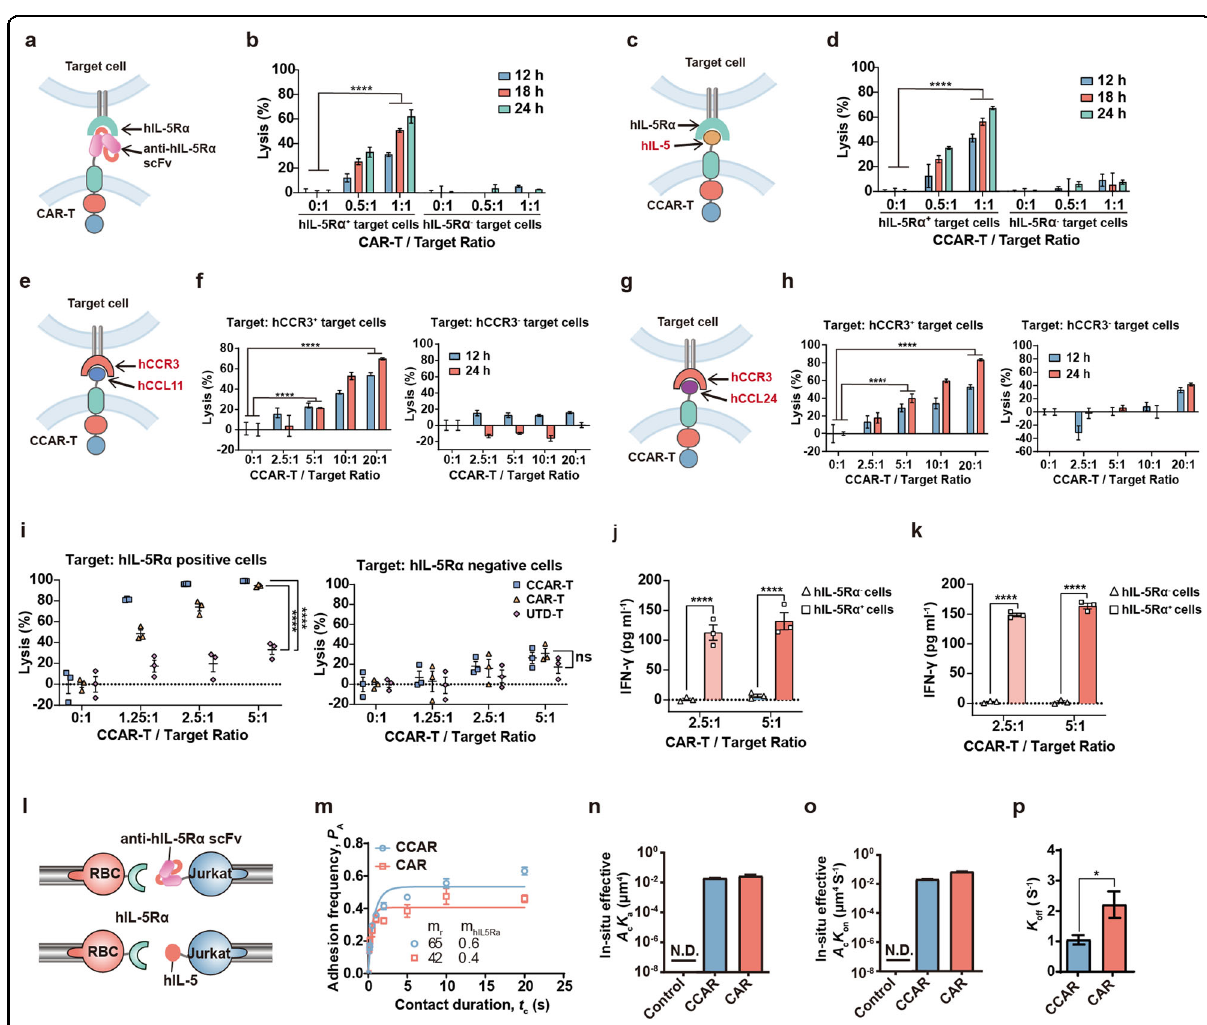
Fig. 1 Design, characterization, and comparison of eosinophil-targeting CCAR-T cells. a Design of the anti-hIL-5R α CAR-T cells using the scFv derived from human IL-5R α mAb as the antigen-binding domain. b Cytotoxic activity of anti-hIL-5R α CAR-T cells as determined by a bioluminescence assay using luciferase-expressing hIL-5R α + or hIL-5R α – U2OS cells as target cells. Differences between the CAR-T cell-treated and control group were examined by the two-way ANOVA, **** P < 0.0001. c Design of the hIL-5-anchored CCAR-T cells using human IL-5 as the antigen-binding domain. d Cytotoxic activity of hIL-5-anchored CCAR-T cells. Two-way ANOVA, **** P < 0.0001. e Design of the hCCL11-anchored CCAR-T cells. f Cytotoxic activity of the CCL11-anchored CCAR-T cells against target cells. Two-way ANOVA, **** P < 0.0001. g Design of the hCCL24-anchored CCAR-T cells. h Cytotoxic activity of the CCL24-anchored CCAR-T cells to target cells. Two-way ANOVA, **** P < 0.0001. i Cytotoxic activity of anti-hIL-5R α CAR-T cells or hIL-5-anchored CCAR-T cells from healthy human donors against hIL-5R α + U2OS cells. Two-way ANOVA, **** P < 0.0001. UTD-T, un-transduced T cells. j , k The production of interferon- γ (IFN- γ ) in the supernatant of anti-hIL-5R α CAR-T cells ( j ) or hIL-5-anchored CCAR-T cells ( k ) from healthy human donors after coculture with target cells for 24 h was determined by ELISA kit. Two-way ANOVA, **** P < 0.0001. l Schematic diagram of the bio- membrane force probe assay for the adhesion frequency assay. m Binding speci fi cities ( P a ) of anti-hIL-5R α CAR/hIL-5-anchored CCAR and hIL-5R α as measured by adhesion frequency with different contact duration. n In-situ effective af fi nity ( A c k a ) of the interaction between anti-hIL-5R α CAR-hIL-5R α or hIL-5-anchored CCAR-hIL-5R α and hIL-5R α . N.D., not detected. o In-situ effective on-rate ( A c k on ) of the anti-hIL-5R α CAR-hIL-5R α bond and the hIL- 5-anchored CCAR-hIL-5R α bond. p Average off-rate ( k off ) of the anti-hIL-5R α CAR-hIL-5R α bond and the hIL-5-anchored CCAR-hIL-5R α bond. Two- tailed t -test, * P <